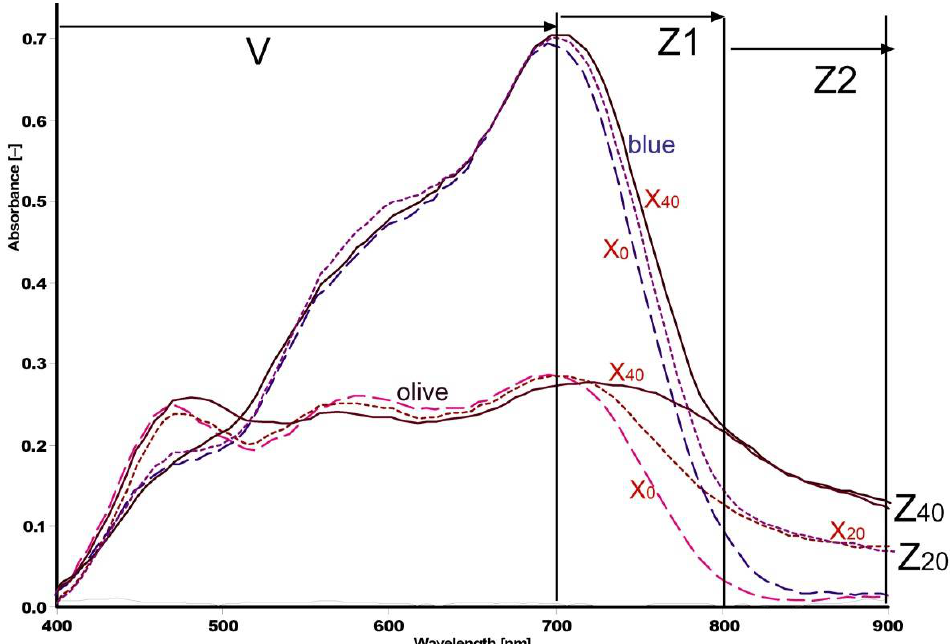
Figure 5. Spectrograms of red color twins (12–Red 2).